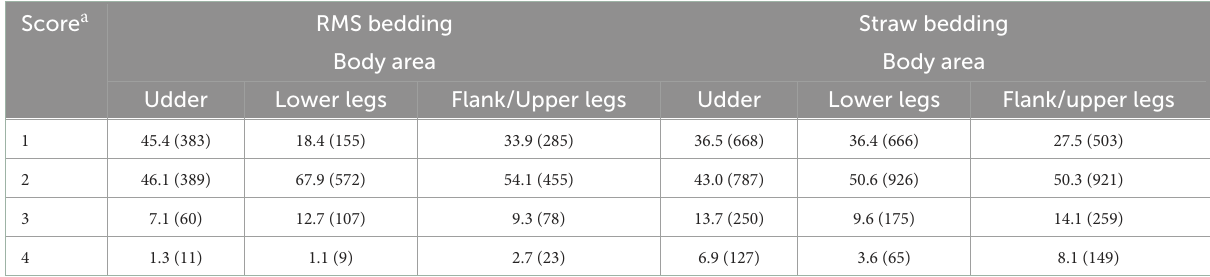
TABLE 2 Percentage (number) of cow’s hygiene score by body region and bedding type obtained on 27 recycled manure solids bedded farms and 61 straw-bedded farms. Score a RMS bedding Straw bedding Body area Body area Udder Lower legs Flank/Upper legs Udder Lower legs Flank/upper legs